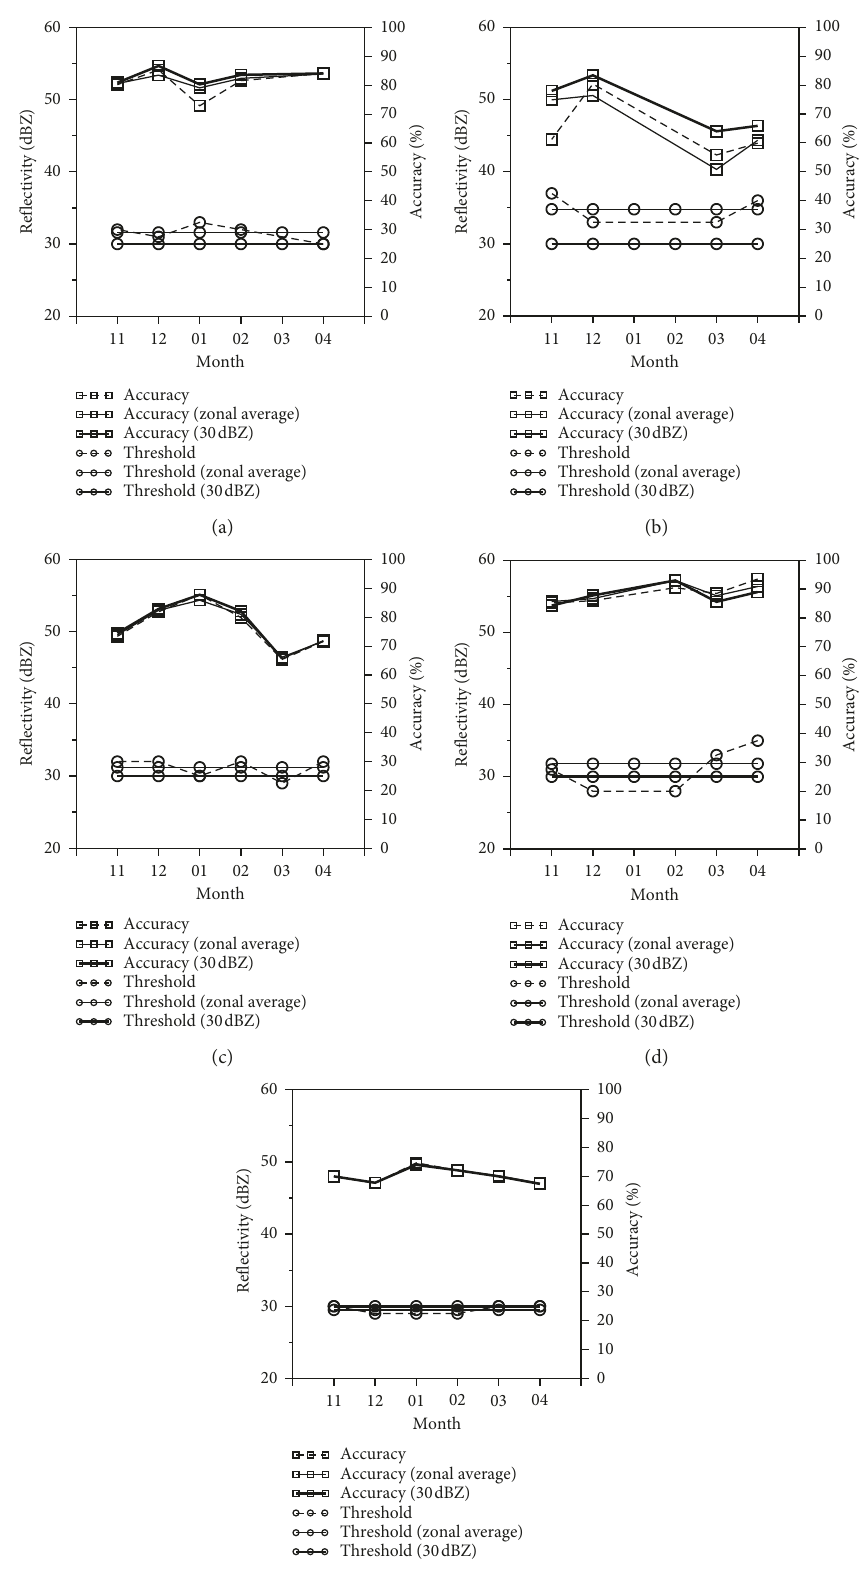
Figure 7: Monthly variation of the threshold radar reflectivity value ( ○ ) and its accuracy ( □ ) for each elevation zone (the zonal-average threshold value and fixed threshold value (30 dBZ) are also given for the comparison): (a) 1,750 m; (b) 1,500m; (c) 1,000m; (d) 500m; (e)